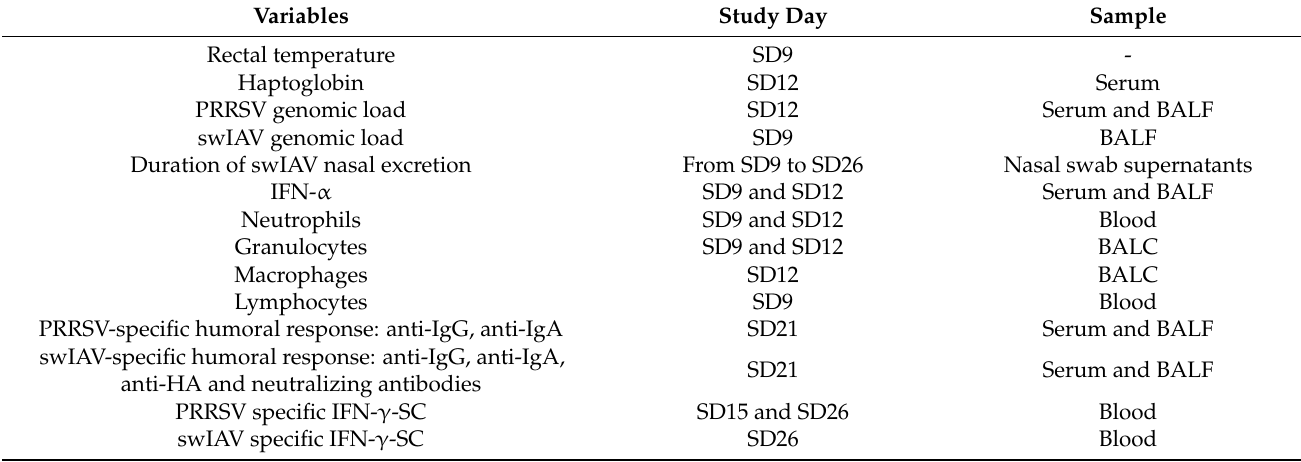
Table 2. List of variables included in principal component